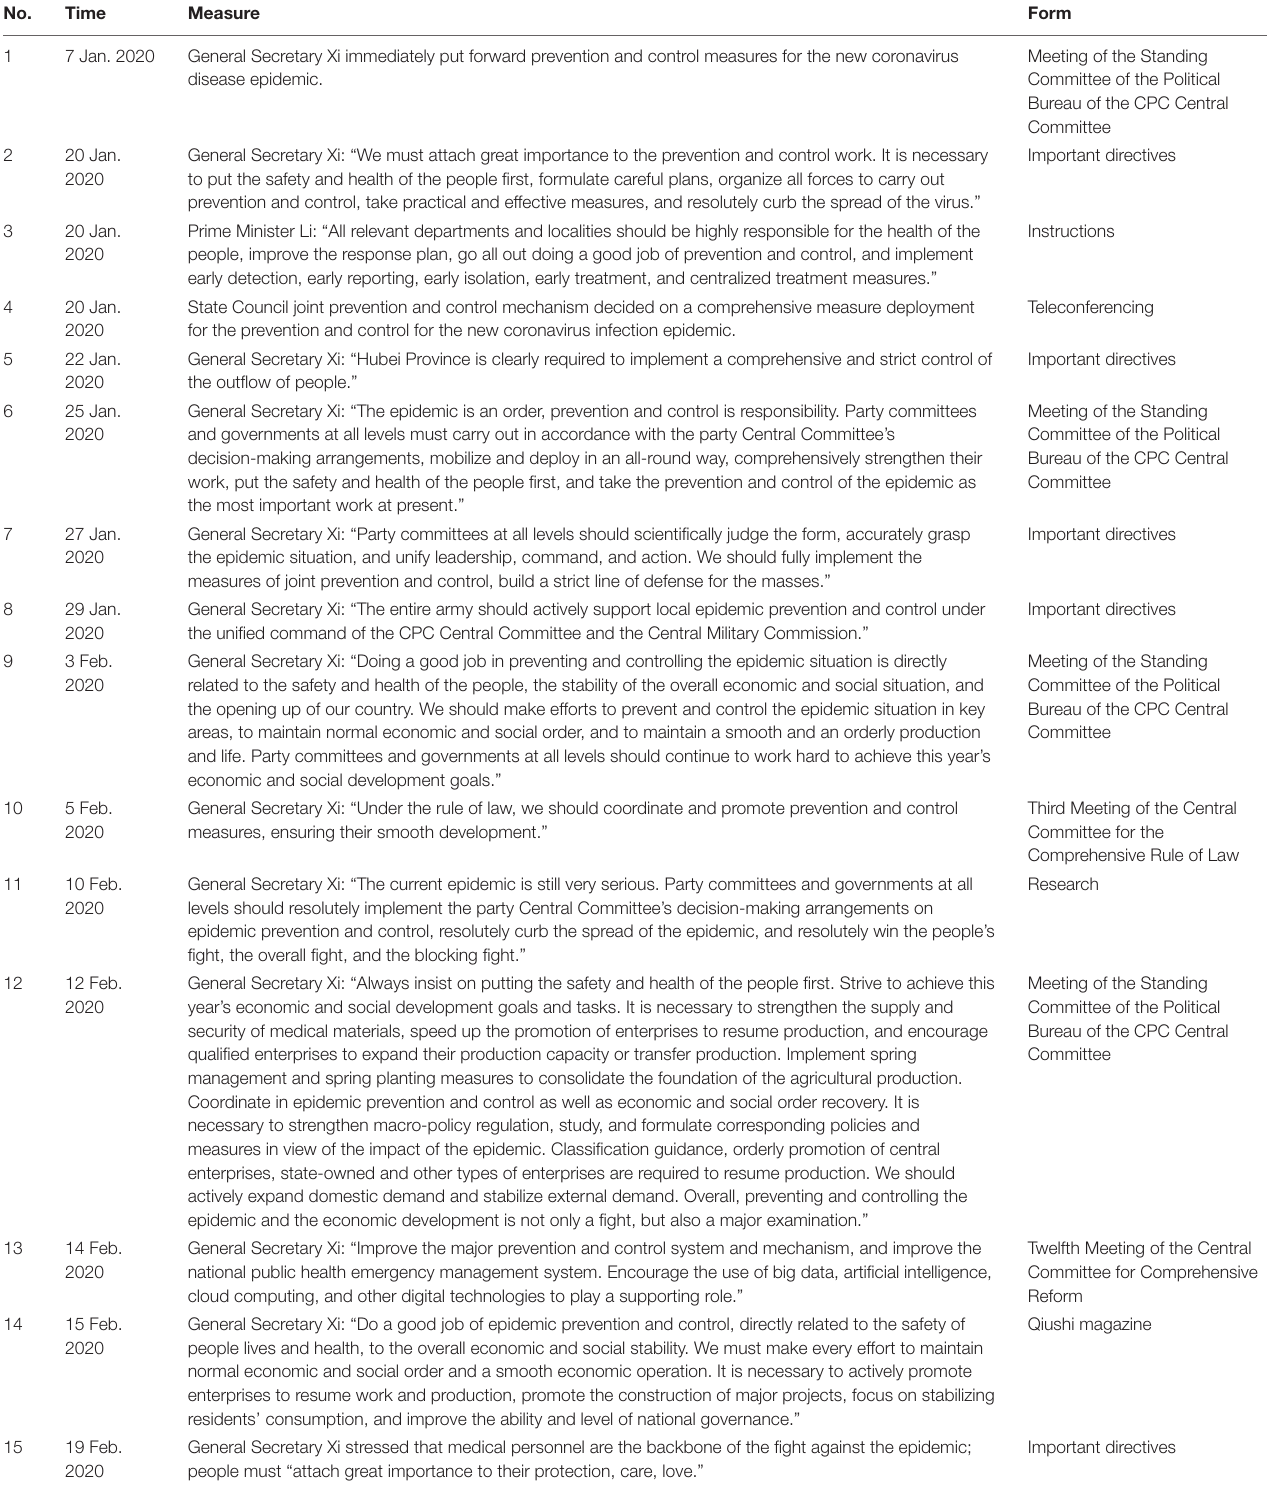
TABLE 1 | The CPC Central Committee’s measures on epidemic prevention and control as well as resumption of work and production during critical periods of outbreak.